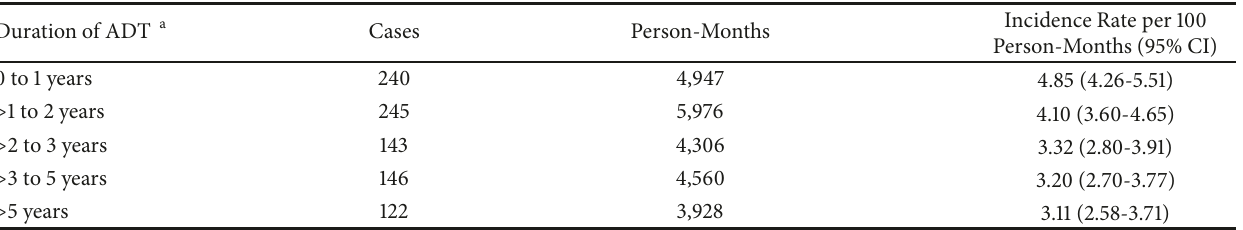
Table 5: Incidence of SREs stratified by duration of androgen deprivation therapy before cohort